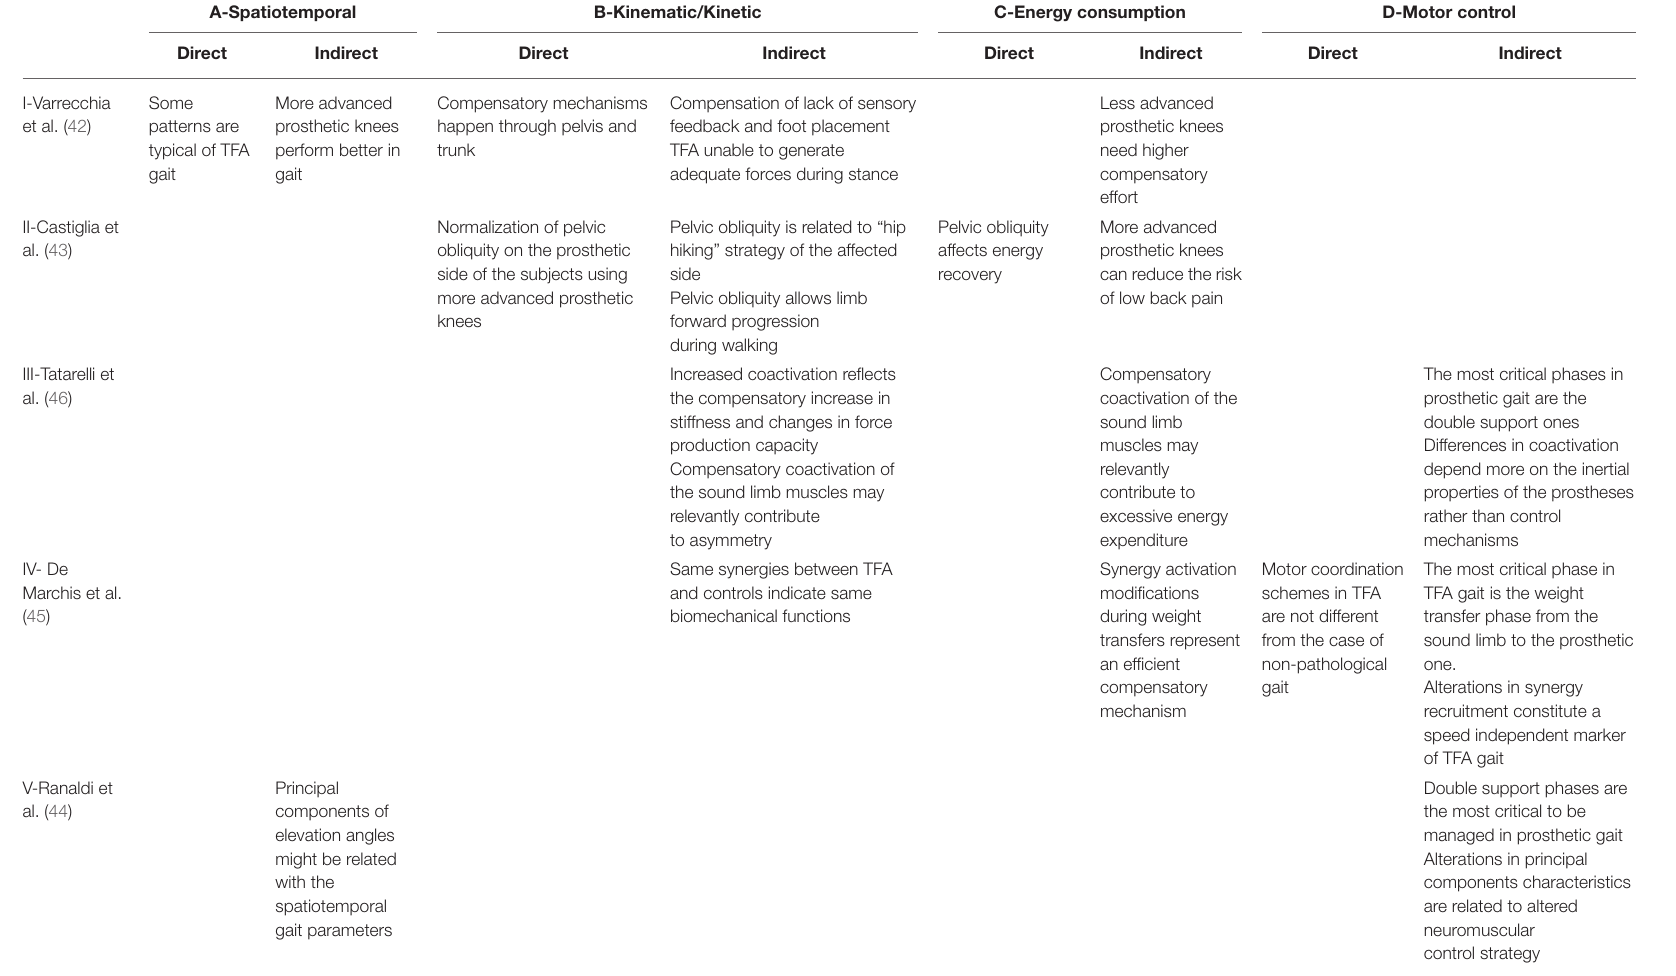
TABLE 2 | Direct and indirect evidence and interpretations emerging from the findings of 5 different